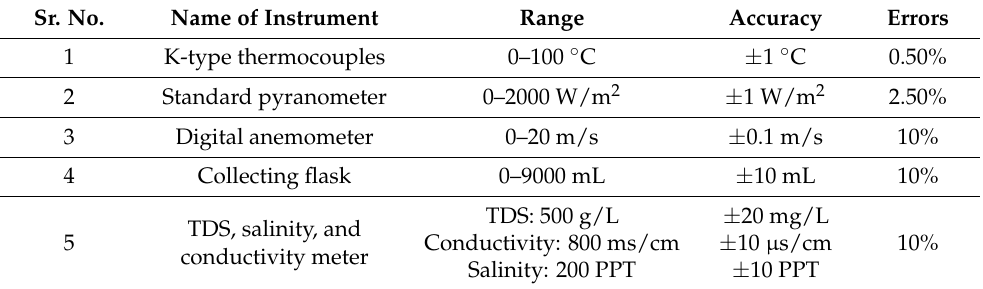
Table 1. Specifications of used instruments. Sr.